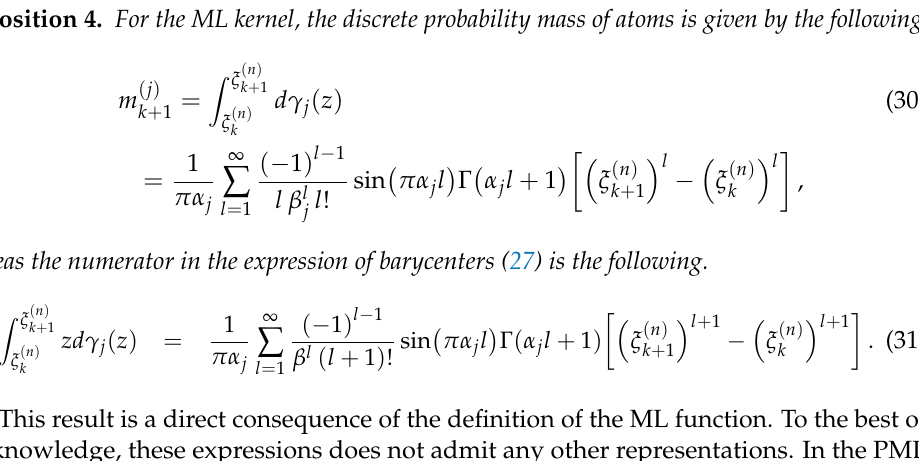
Figure 4. Left and right plots: measures γ ( . ) of the Mittag–Leffler (ML) and power Mittag–Leffler (PML) kernels. β =